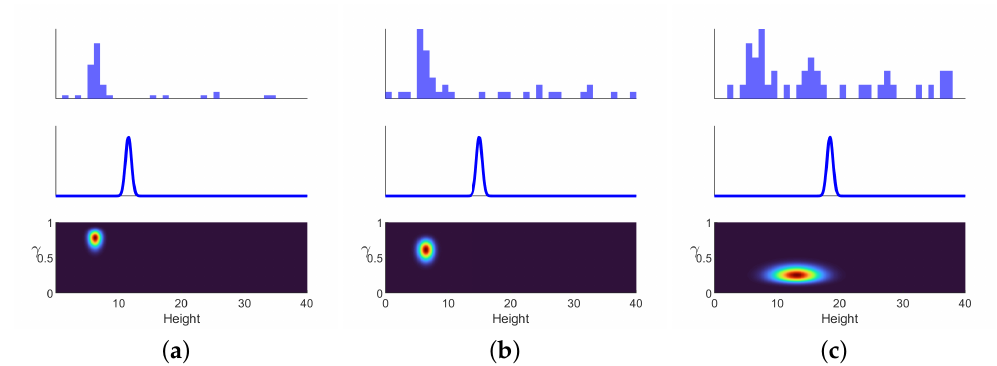
Figure 4. Posterior distribution for height. The top row shows the histograms of 40 height mea- surements corrupted by the outlier. The second row shows the posterior distributions for h when the height measurements are modeled with a single variant Gaussian distribution. The bottom row shows the 2D posterior distribution estimated by the proposed method, where the vertical axis is for inlier probability γ and the horizontal axis is for height h . The true height value for this simulation is h = 5 m; ( a ) 40 height measurements with 1/4 outliers; ( b ) 40 height measurements with 1/2 outliers; ( c ) 40 height measurements with 3/4